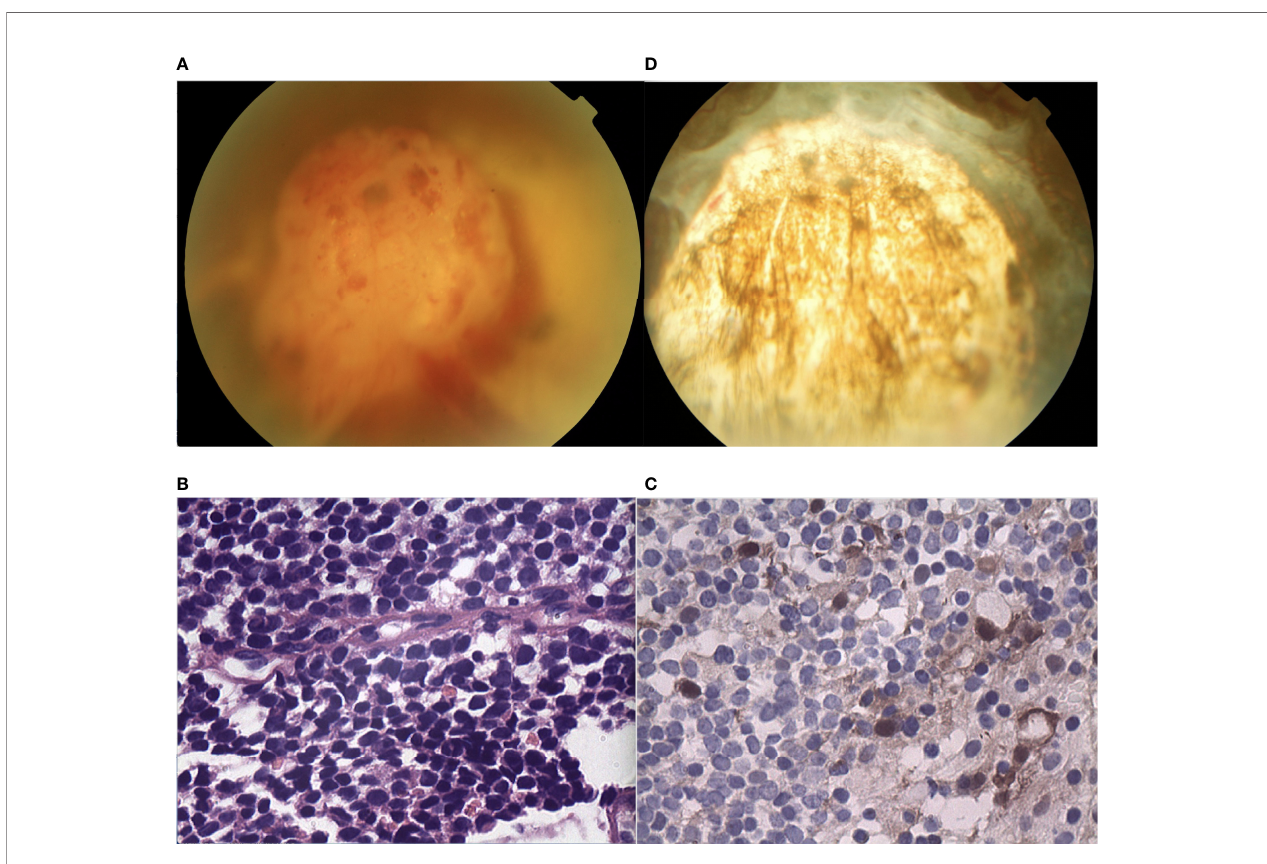
FIGURE 3 | (A) In the fundus of the right eye of patient 3, there was a white, dome-shaped lesion of the retina in the inferotemporal fundus, with fi ne vitreous hemorrhage. The central portion appeared nodular and fi brotic with subtle tortuous retinal vessels. The vitreous seeds were unclear. (B, C) Pathology and immunohistochemistry results revealed the foci of (B) Flexner-Wintersteiner rosettes that were (C) S100 positive. (D) In the last follow-up, the retina was well- attached and there was slight proliferation in the defect area of the